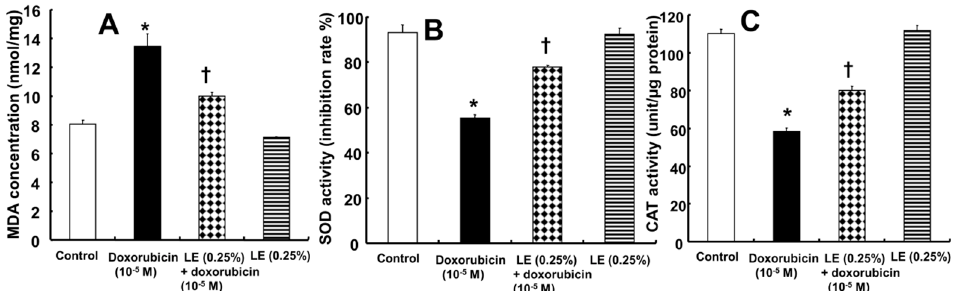
Figure 5. Effects of Intralipid ® (lipid emulsion, LE) on doxorubicin-induced oxidative stress in H9c2 rat cardiomyoblasts. H9c2 cells were treated with doxorubicin alone (10 − 5 M) for 24 h, LE (0.25%) for 1 h followed by doxorubicin (10 − 5 M) for 24 h, or LE (0.25%) alone for 25 h. The levels of malondialdehyde (MDA, A ), a marker of lipid peroxidation, superoxide dismutase (SOD, B ) activity and catalase (CAT, C ) activity in different treatment groups were measured and compared with those in the control. Data are presented as the mean ± SD (N = 3). * p < 0.001 versus control. † p < 0.001 versus doxorubicin alone.